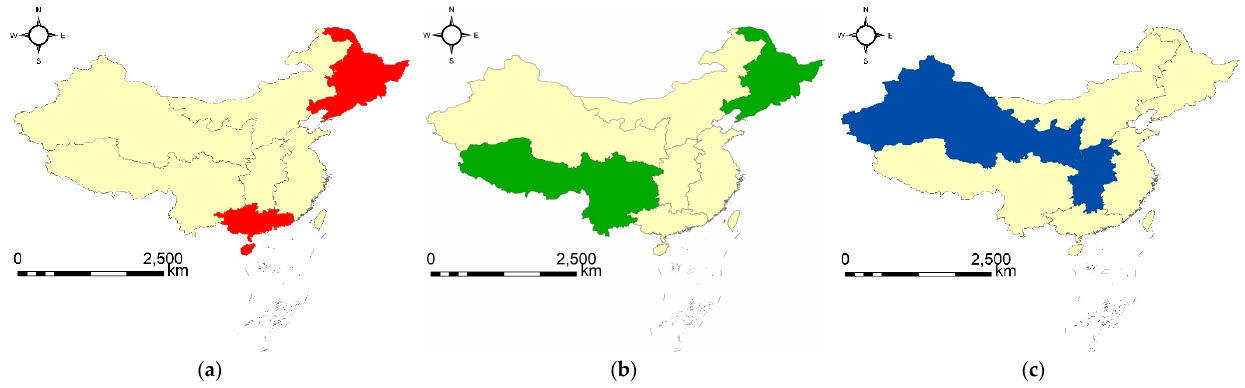
Figure 8. The discovered geographical flock patterns: ( a ) {2, 5}|[2005, 2008] (type I, III), ( b ) {2, 6}|[2013, 2016] (type I, III), and ( c ) {4, 7}|[2014, 2016] (type II, IV). Table 6. The discovered geographical flock patterns based on the criterion of the extreme number- duration values on the geographical region level.